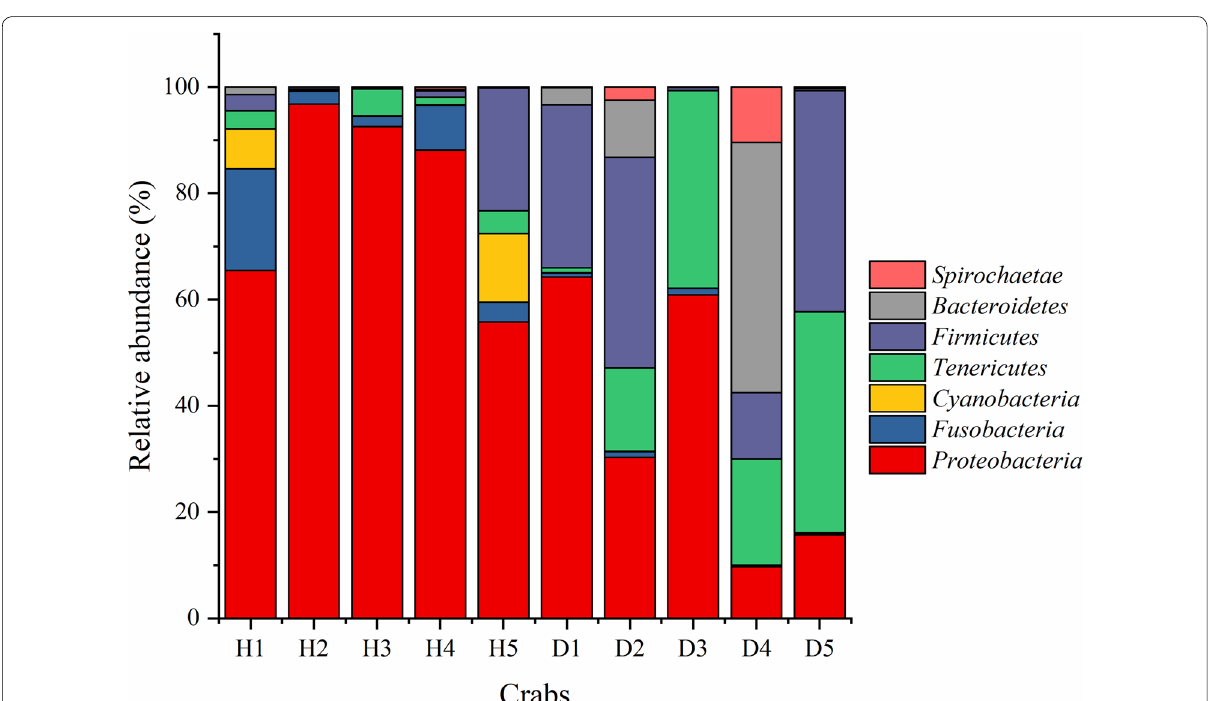
Fig. 1 Relative abundance of the dominant (relative abundance > 5% at least in one sample) phyla within different